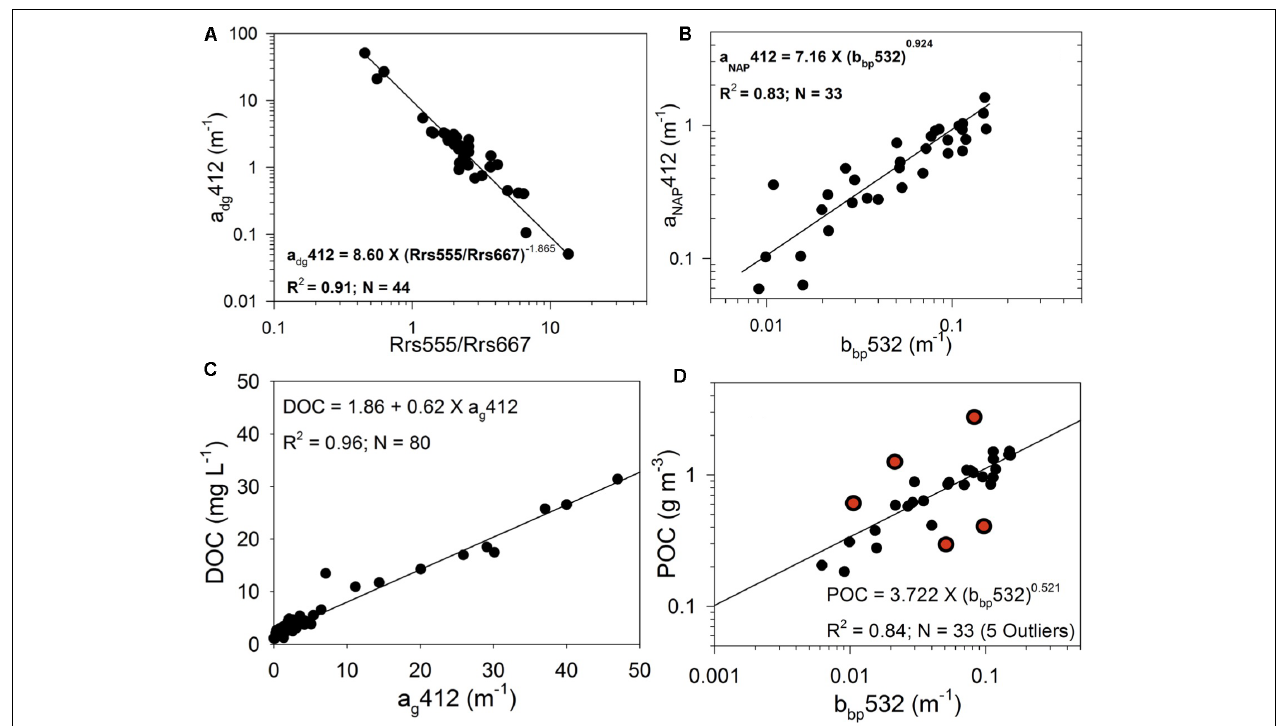
FIGURE 5 | in situ chemo-optical relationships. (A) MODIS-Aqua remote sensing reflectance band ratio (R rs 555/R rs 667) vs. a dg 412 nm; (B) particle backscattering at 532 nm ( b bp 532 ) vs. a NAP 412 nm; (C) a g 412 vs. DOC; and (D) b bp 532 vs.